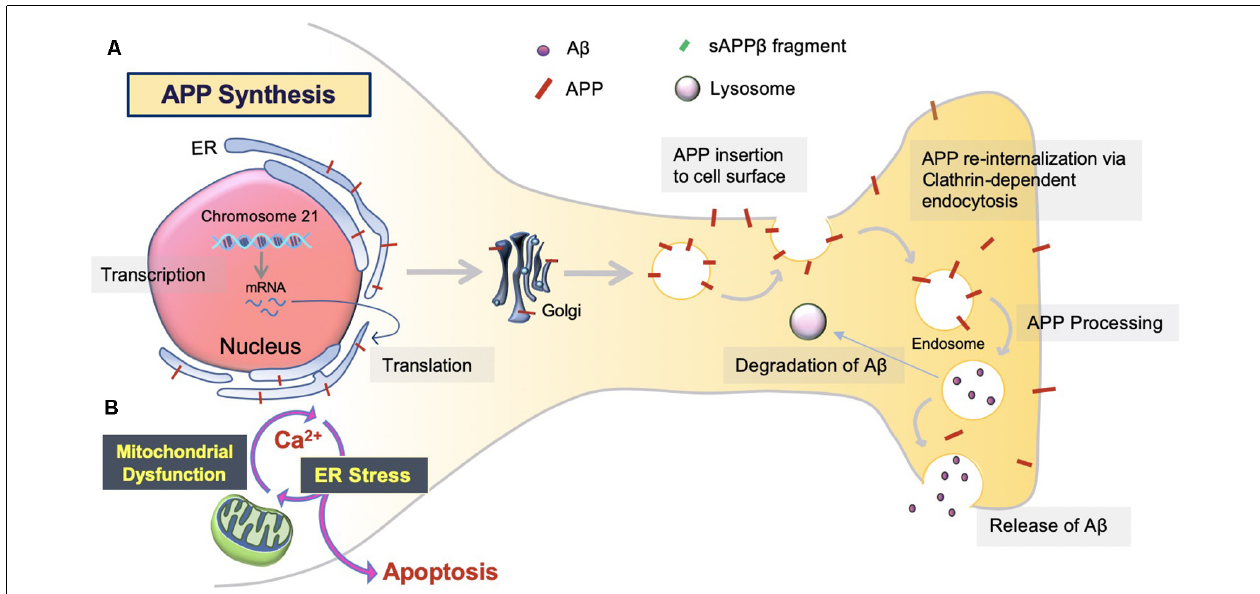
FIGURE 1 | Amyloid precursor protein (APP) synthesis and trafficking. (A) APP synthesis. APP synthesis commences with transcription on chromosome 21. Then, it is translated by endoplasmic reticulum (ER) bound ribosomes, translocated into the ER, and trafficked to the Golgi to assume native structure and folding (Sun et al., 2015; Sole-Domenech et al., 2016). Eventually, the APP is inserted into the plasma membrane and reinternalized to produce A β . Otherwise, APP can be redirected to non-amyloidogenic pathways by the retromer complex and transported back to the Golgi or plasma membrane via the recycling pathway. Nascent A β peptides are either extracellularly released or degraded by the lysosome (Hernández-Zimbrón and Rivas-Arancibia, 2014). (B) ER stress. A β toxicity responds with consequential disruption of Ca 2+ permeability via mitochondria-associated membrane (MAM), mitochondrial Ca 2+ uptake, and eventual apoptosis.